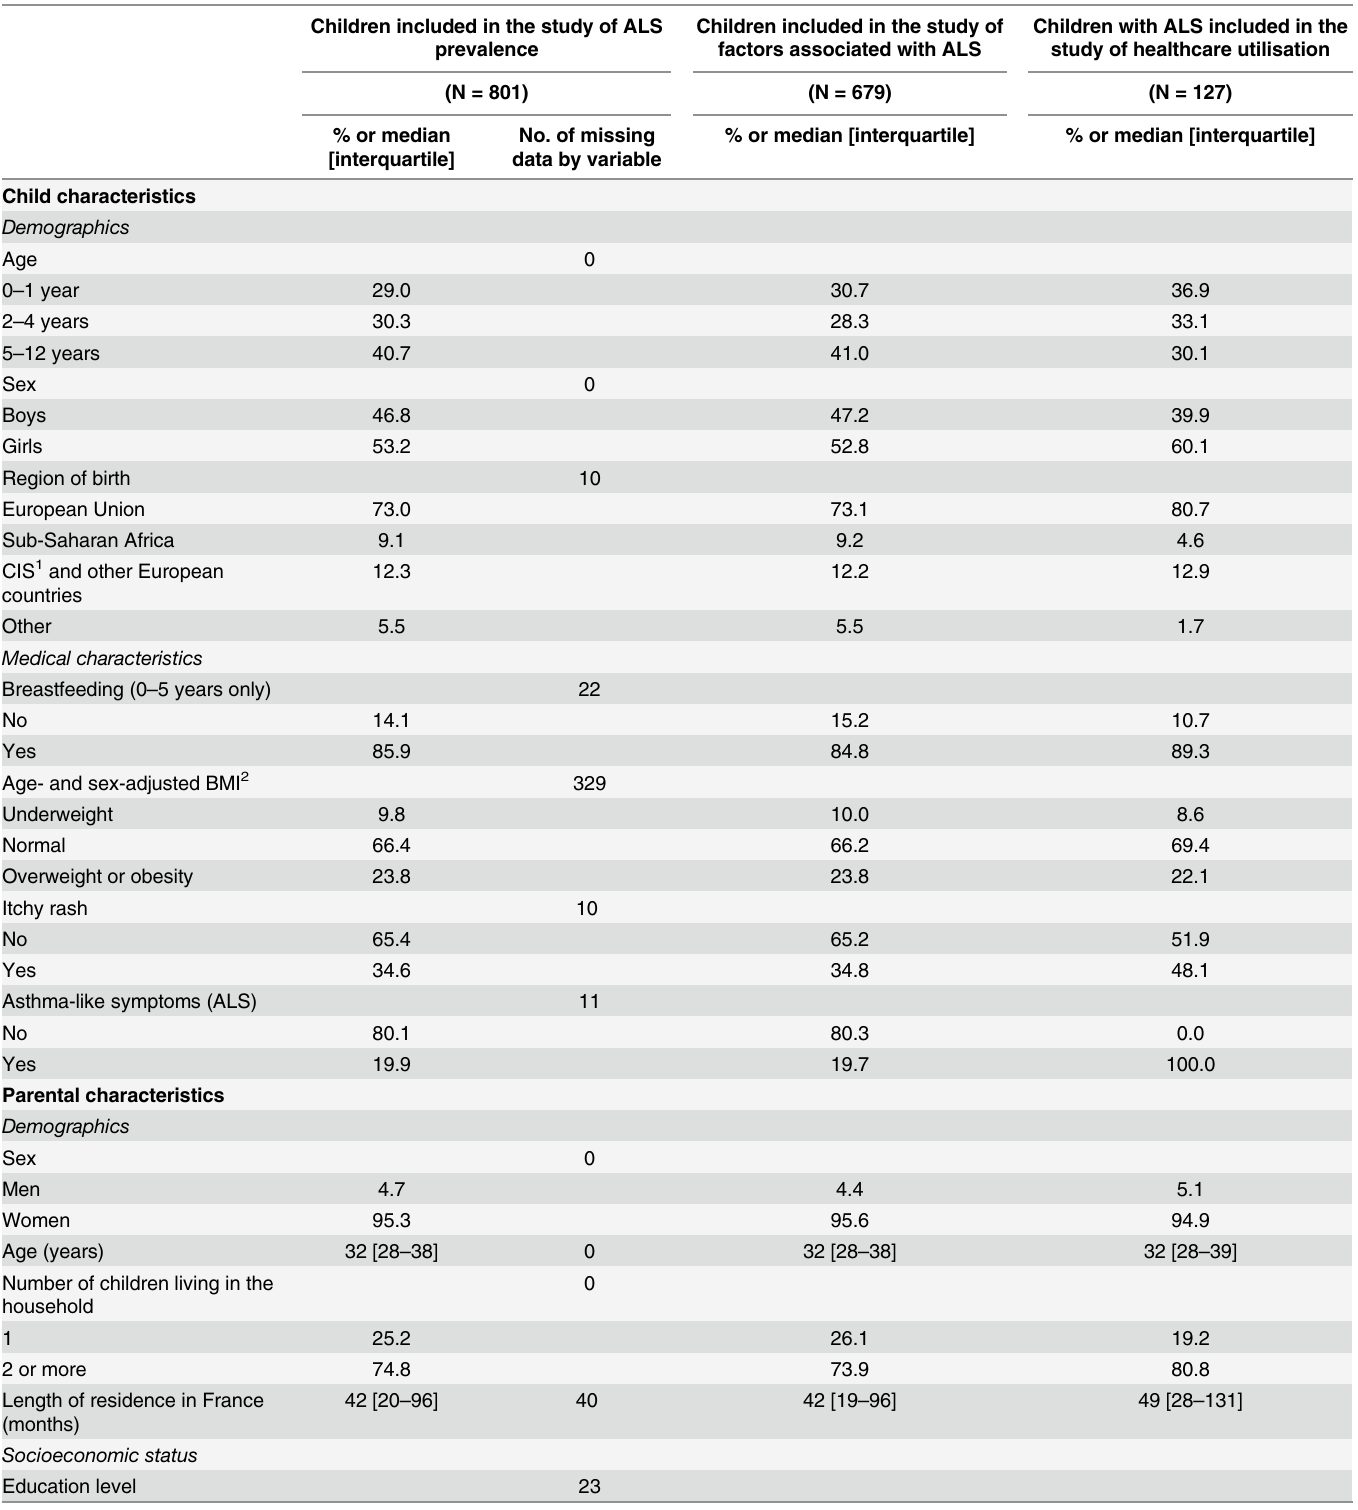
Table 1. Population's